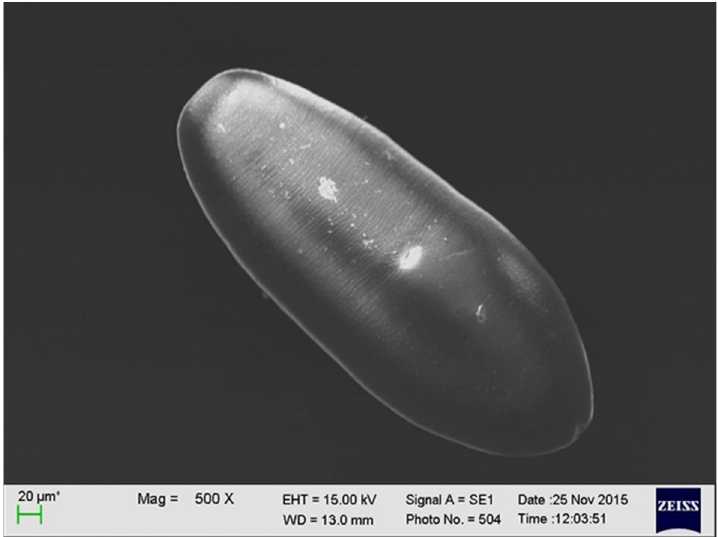
Figure 2. The larval stage of A. alata detected in the muscle tissue of a wild boar (by M. Wasiak).